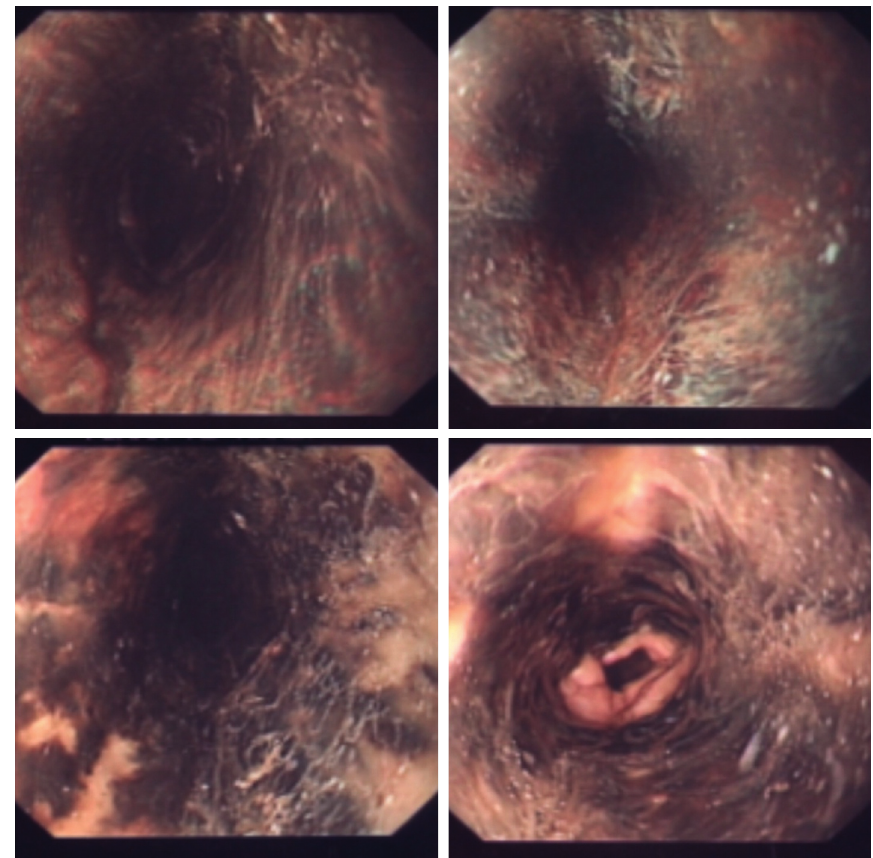
Figure 1: A view of the patient’s esophagus showing black discoloration confirming the diagnosis of acute esophageal